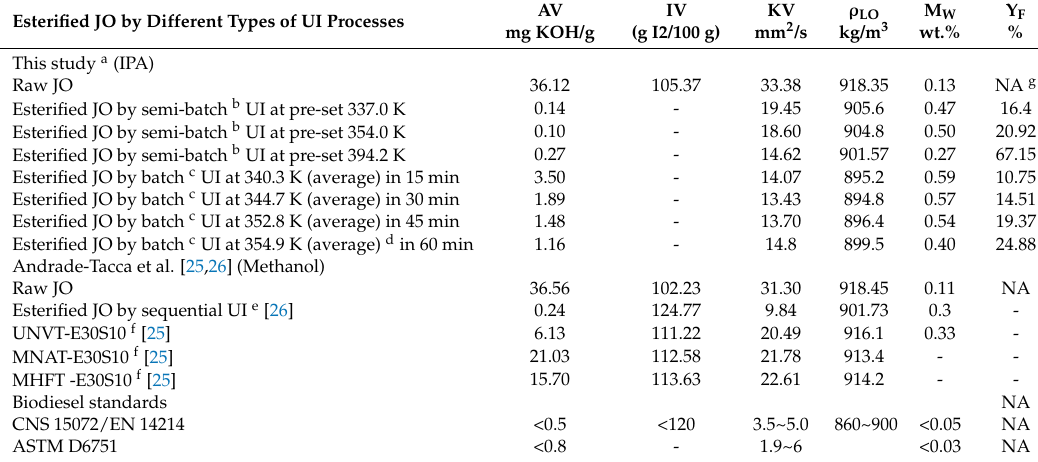
Table 3. Comparisons of properties of esterified JOs from semi-batch and batch UI processes using IPA/H of this study with those from sequential UI [26] using methanol/H 2 SO 4 (M/H) and biodiesel